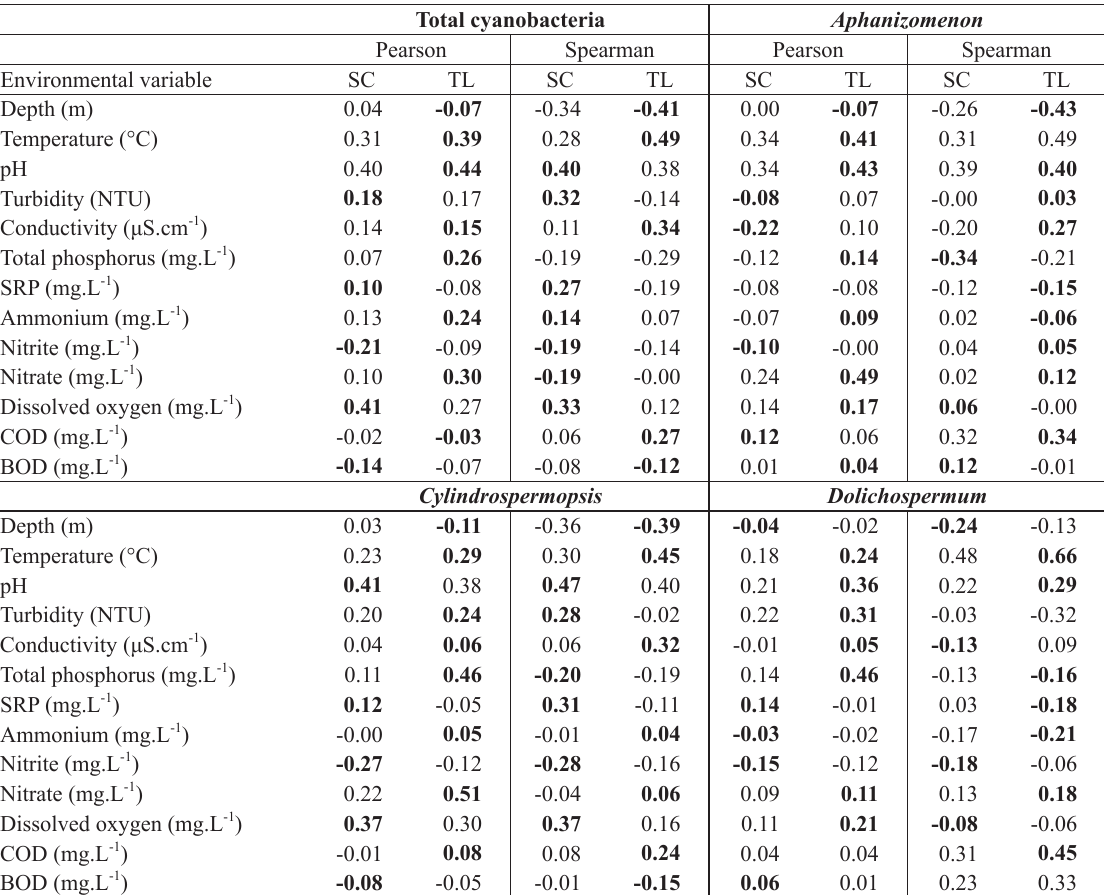
Pearson and Spearman correlation coefficients between environmental variables and cyanobacterial density (cell.mL -1 ) considering the simultaneous correlation (SC) and “time lag” correlation (TL) (see methods, highest values are in bold for each comparison). COD = chemical oxygen demand, BOD = biochemical oxygen demand, SRP = soluble reactive